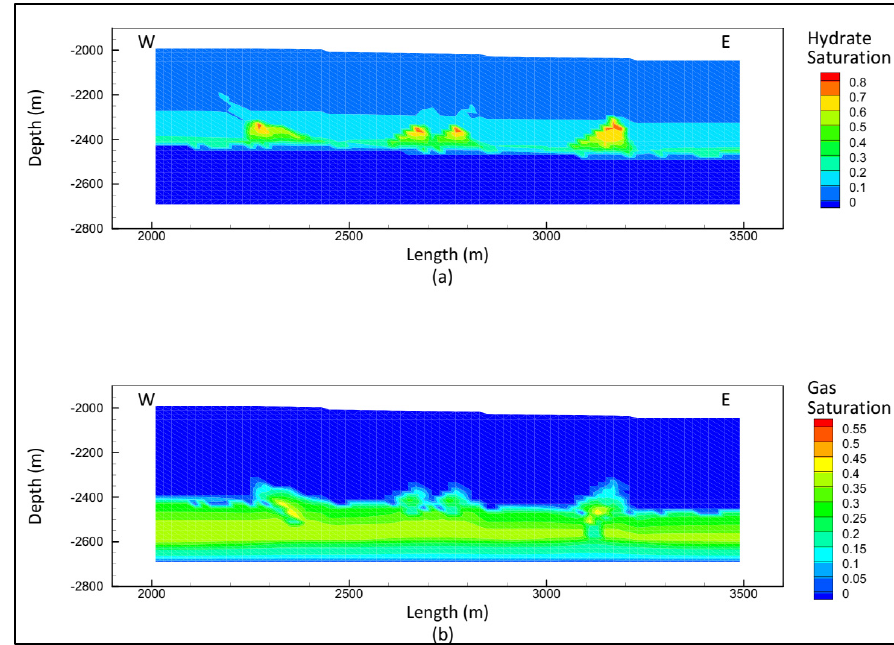
Figure 5. Hydrate formation after fifteen thousand years in the reservoir domain. ( a ) The hydrate saturation reaches a maximum of 82% and is distributed along length of the reservoir model, with peaks along faults and highly permeable regions. ( b ) The underlying gas layer with notable chimney structures is observed consistently with fi eld observations at Green Canyon.